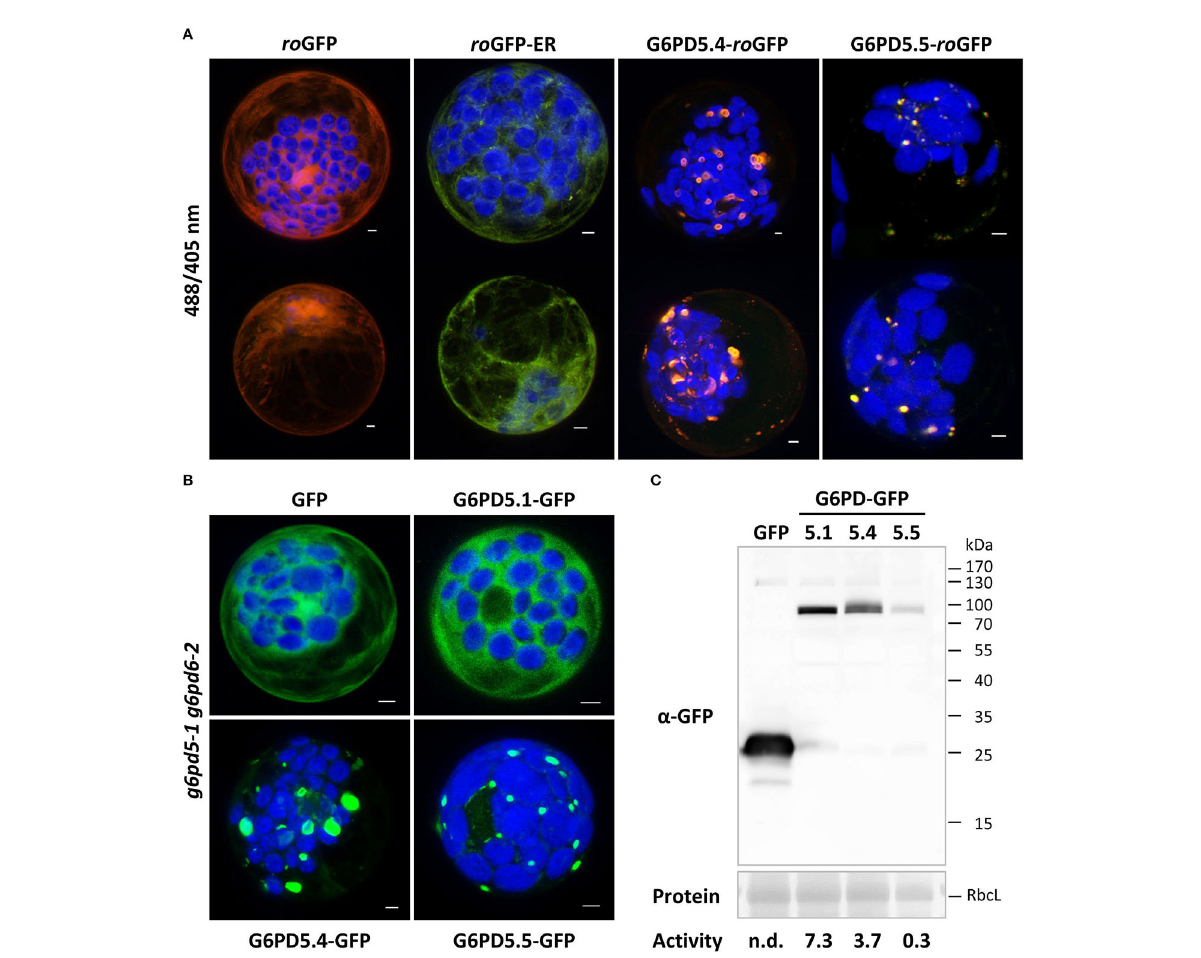
FIGURE5 Topology and functionality of the membrane-bound G6PD5.4 and G6PD5.5 proteoforms. (A) Redox-sensitive GFP ( ro GFP) was used to demonstrate that the catalytic domains of G6PD5.4 and G6PD5.5 face the cytosol. Two representative cells are shown for each construct. Note that the 488/405 ratios resemble cytosolic ro GFP (red-orange/yellow) and not luminal ro GFP-ER (green). For single channel images, refer to Supplementary Figure S4. (B) Protoplasts were prepared from g6pd5-1 g6pd6-2 double-mutant plants (lacking cytosolic G6PDH activity) and transfected with the indicated G6PD5-GFP fusions. The images show maximal projections of about 30 optical sections as a merger of both channels. GFP in green, chlorophyll autofluorescence in blue. Scale bars, 3 µ m. (C) Immunoblot analysis of protoplast extracts (separated on a 12% SDS gel) using anti-GFP antibodies ( α -GFP). Protein, Ponceau S-stained blot, with RbcL (RubisCO, Large subunit) as loading reference. Molecular mass standard (in kDa), PageRuler Prestained Protein Ladder (Fermentas). Activity, volume equivalents of NADPH formed (nmol/min/ml), which was not detectable (n.d.) for the control (GFP). Note that enzymatic activity of the G6PD5-GFP fusions (bottom) corresponds to the intensity of their respective blot signals, indicating that the membrane-bound proteoforms form active homomers at the ER.